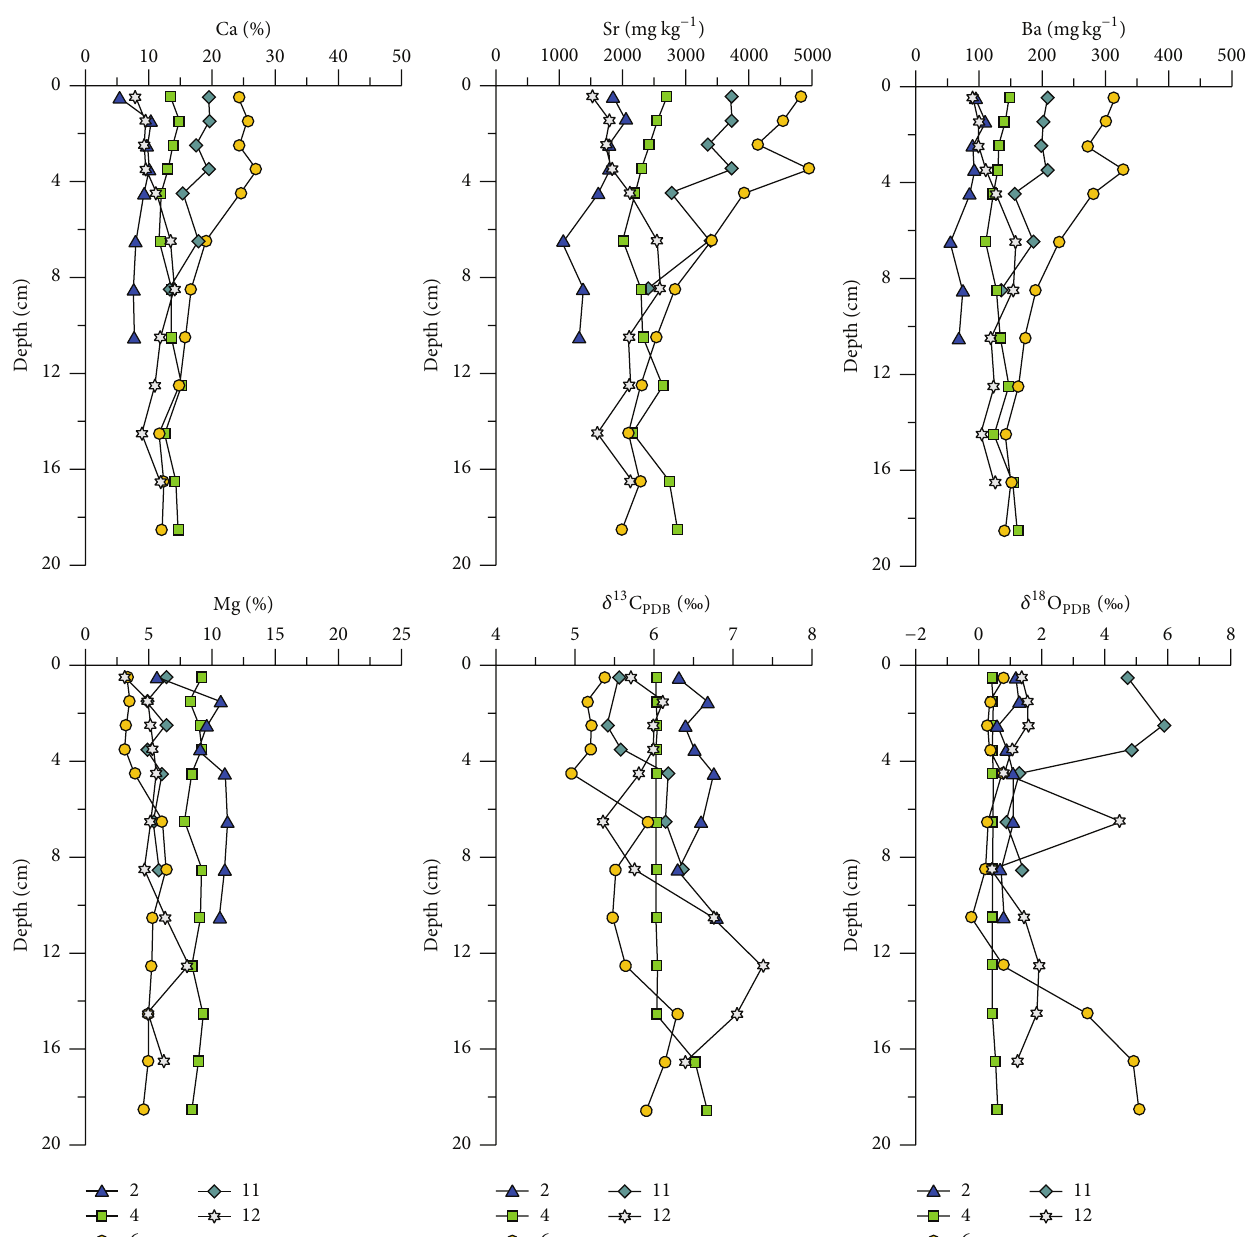
Figure 6: Depth profiles of Ca (%), Sr (mgkg −1 ), Ba (mgkg −1 ), and Mg (%) concentrations and carbon and oxygen isotopic composition of carbonate phases ( 𝛿 ‰) for lake Specchio di Venere sediment